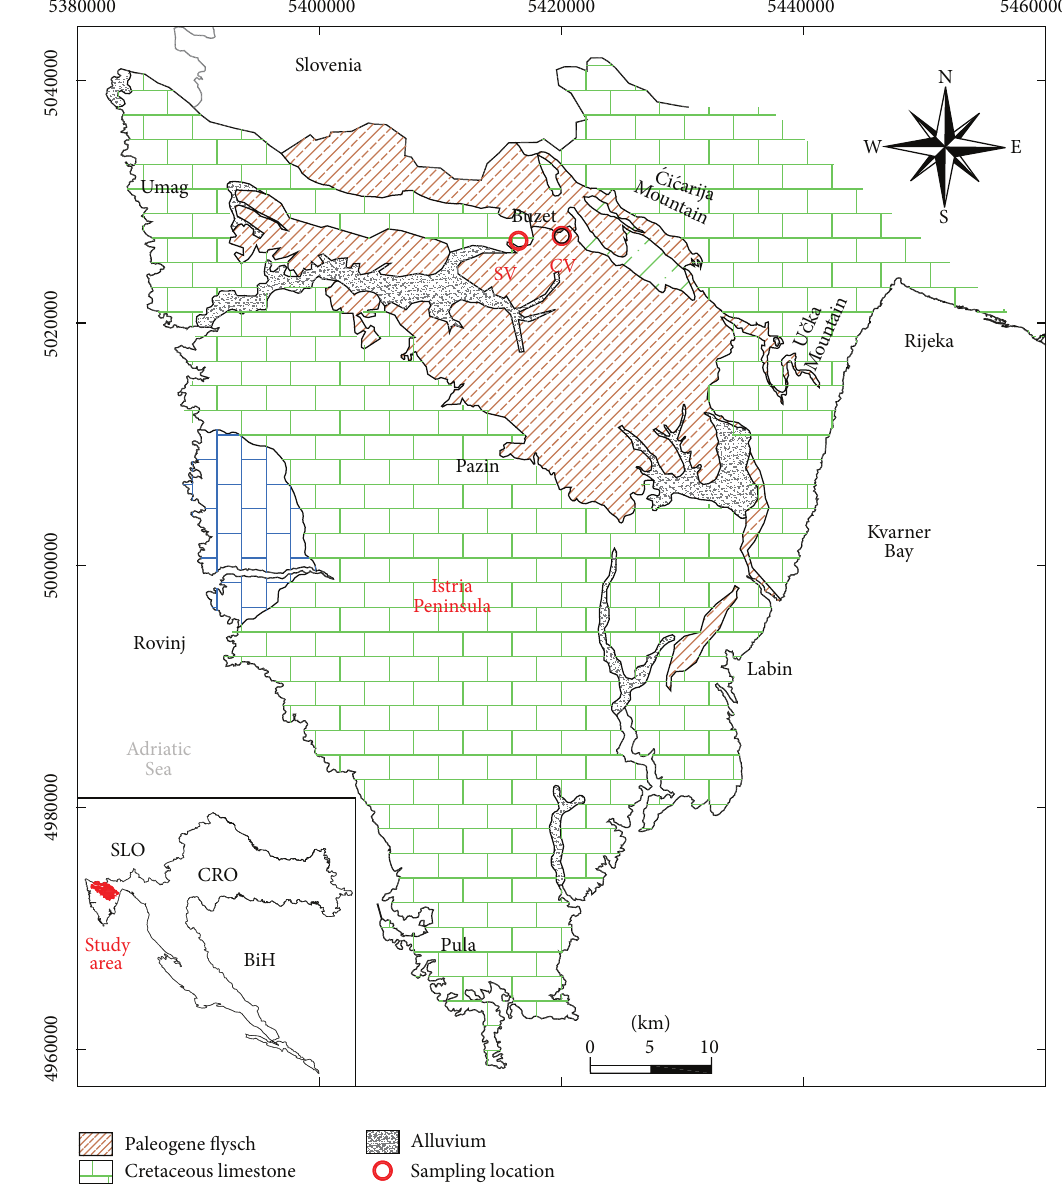
Figure 1: Geological map of the Istria Peninsula (based on [19]). CV = Cunj Village, SV = Sovinjak